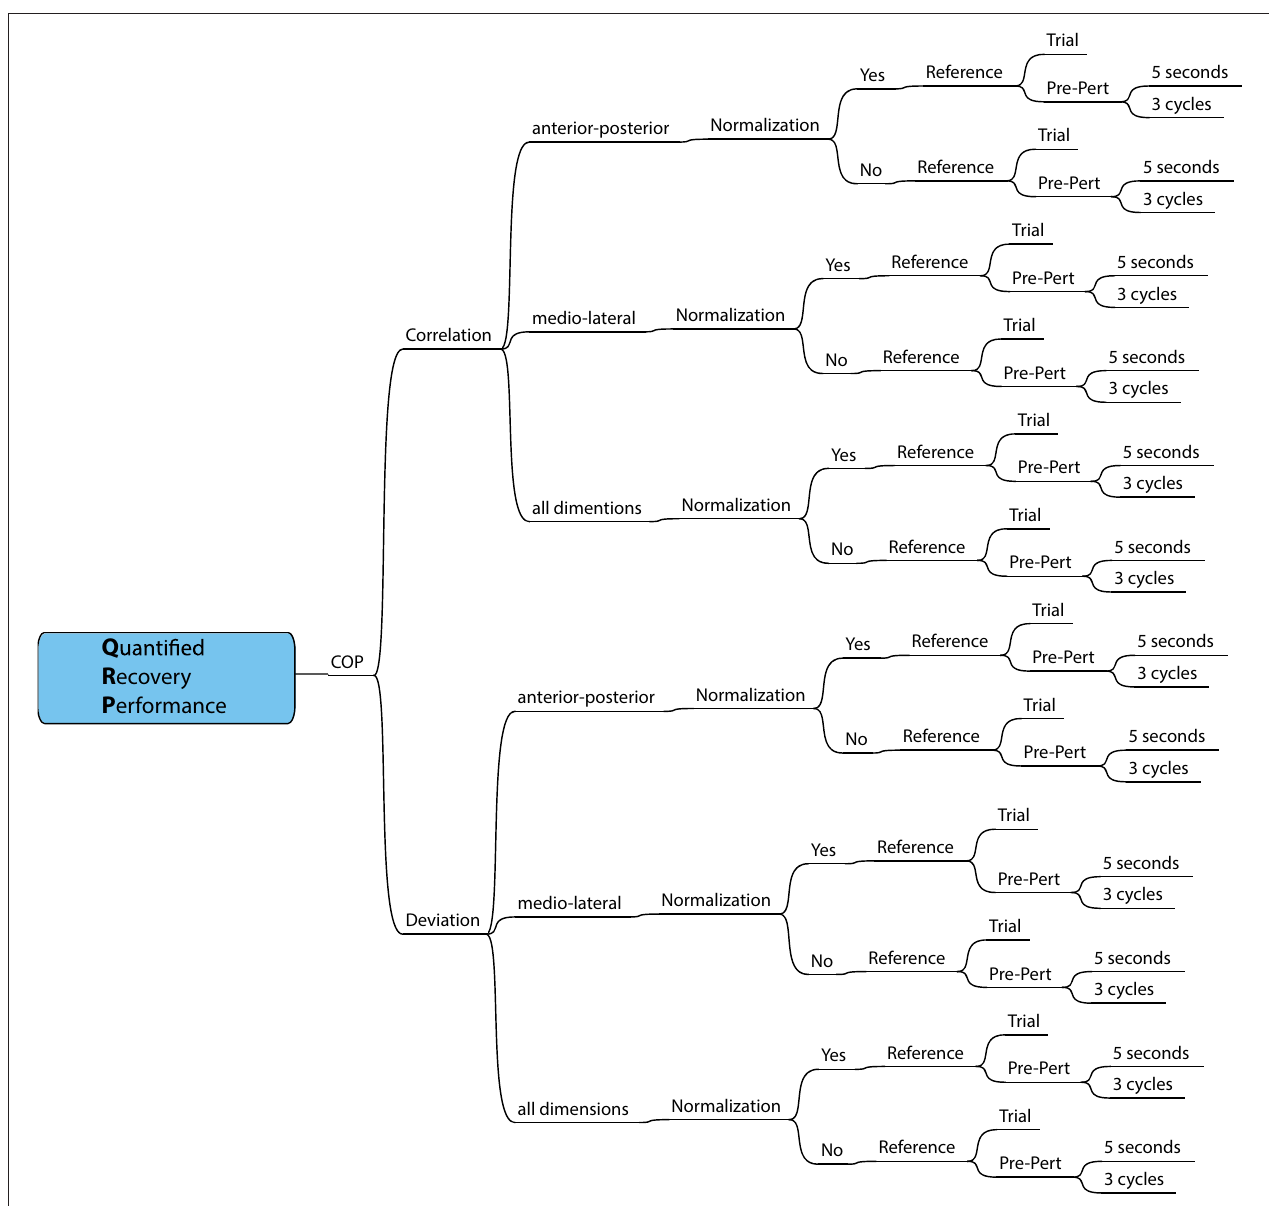
FIGURE 1 | Schematic overview of methodological choices in data processing, resulting in 36 QRP measures.